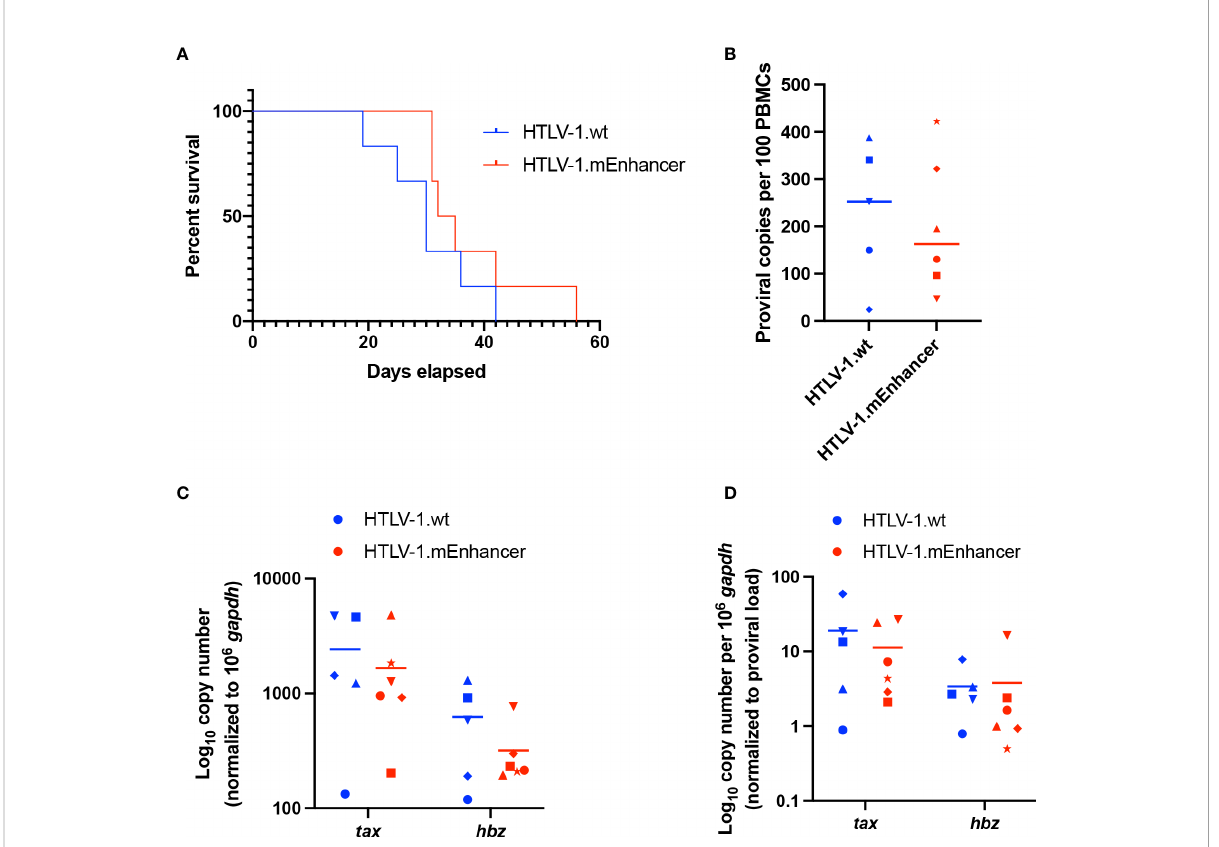
FIGURE 5 Loss of enhancer element has no effect on disease progression in HIS mice. Sub-lethally irradiated neonatal NSG received liver injections of 3 x 10 4 to 1 x 10 5 of CD34 + HUSC. 10 weeks after HUSC engraftment, mice were inoculated intraperitoneally with 1 x 10 7 lethally irradiated 729 HTLV-1.wt or 729 HTLV-1.mEnhancer producer cells. (A) HTLV-1 infection induces lymphoproliferative disease in the mice, and survival rate was determined for animals inoculated with wt compared to mEnhancer virus. Mice were euthanized according to early removal criteria de fi ned in the approved animal protocol. Statistical signi fi cance was determined by Log-rank (Mantel-Cox) test. (B) Genomic DNA was extracted from PBMCs isolated from mouse spleens and used for qPCR to detect proviral load using primers targeting HTLV-1 Gag/pol. Statistical signi fi cance was determined by Welch ’ s unpaired t test. (C) RNA extracted from hPBMCs was subjected to cDNA synthesis followed by qPCR to detect viral gene expression. Data are shown normalized to 1 x 10 6 hgapdh copies. (D) The levels of viral transcripts were evaluated by normalizing Tax